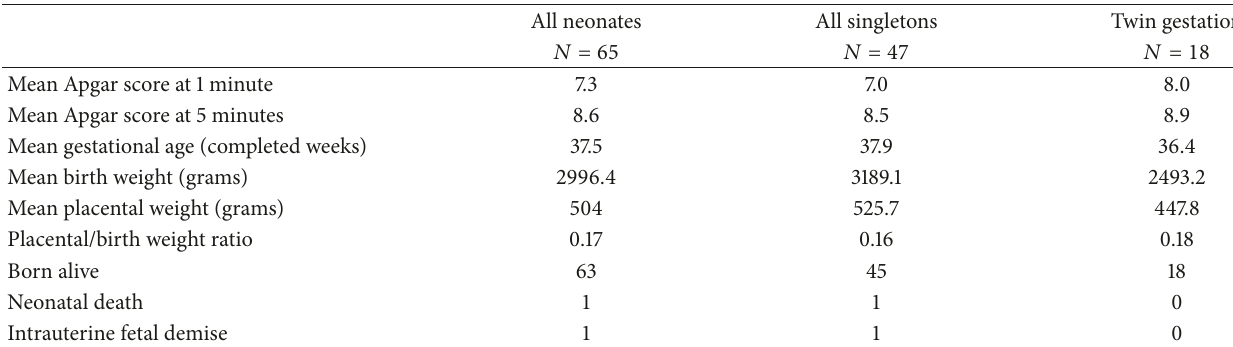
Table 3: Neonatal